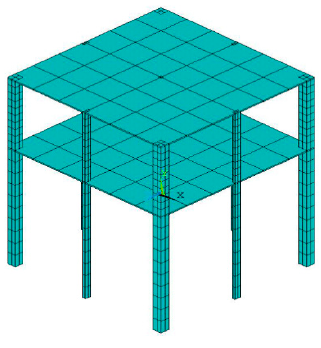
Figure 10. Finite element model.